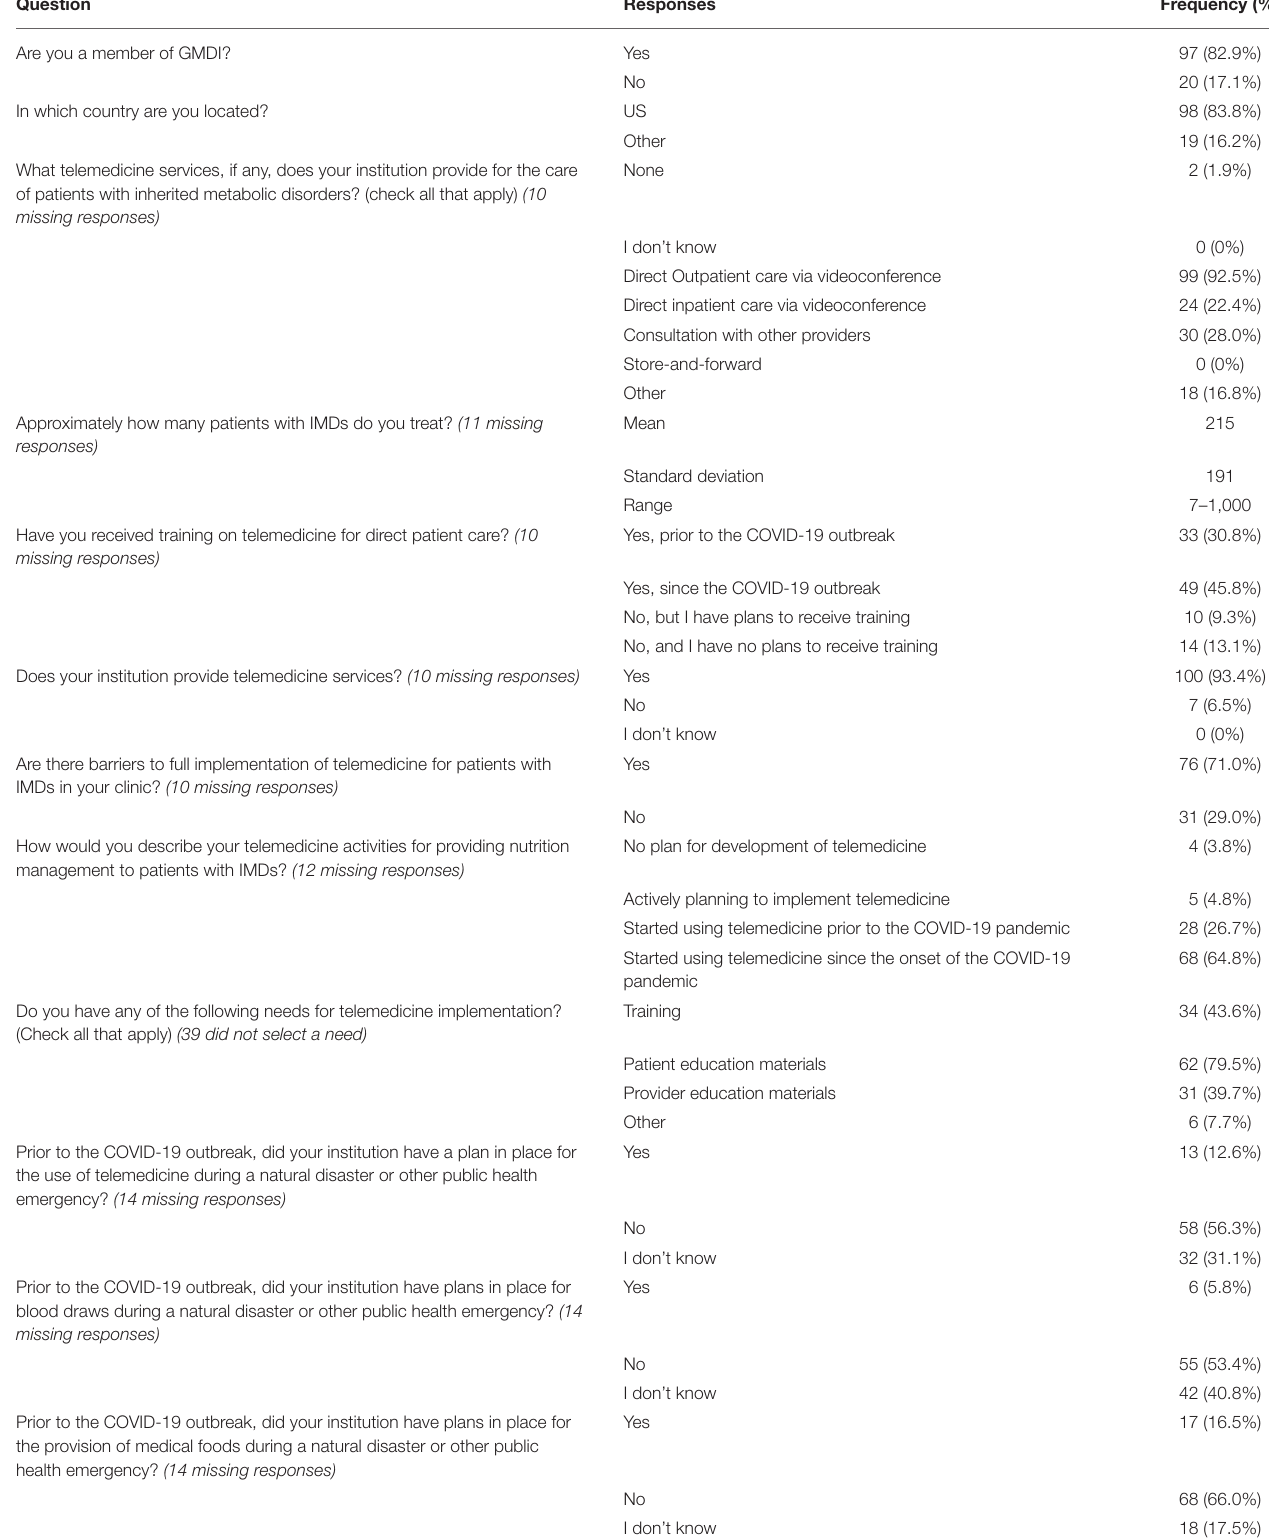
TABLE 1 | Characteristics of RDs who provide nutritional management for patients with IMDs ( N = 117). Question Responses Frequency (%) Are you a member of GMDI? In which country are you